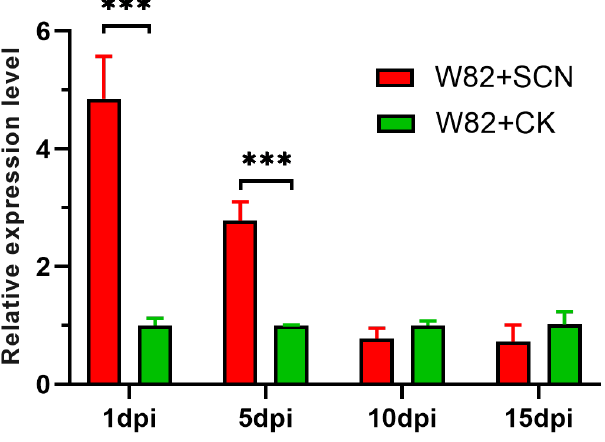
Figure 3. Quantitative Real-time PCR validations of soybean cyst nematode responsive miRNAs in the susceptible soybean cultivar Williams 82. Soybean cyst nematode infected Williams 82 plants were named as W82+SCN, the non-infected as W82+CK. The level of expression was normalized to the level of U6 . Each bar shows the mean ± SE of triplicate assays. Multiple t-tests were applied to analyze the difference betweeen W82+SCN with W82+CK. *** indicates a statistically significant difference as a relative at p <